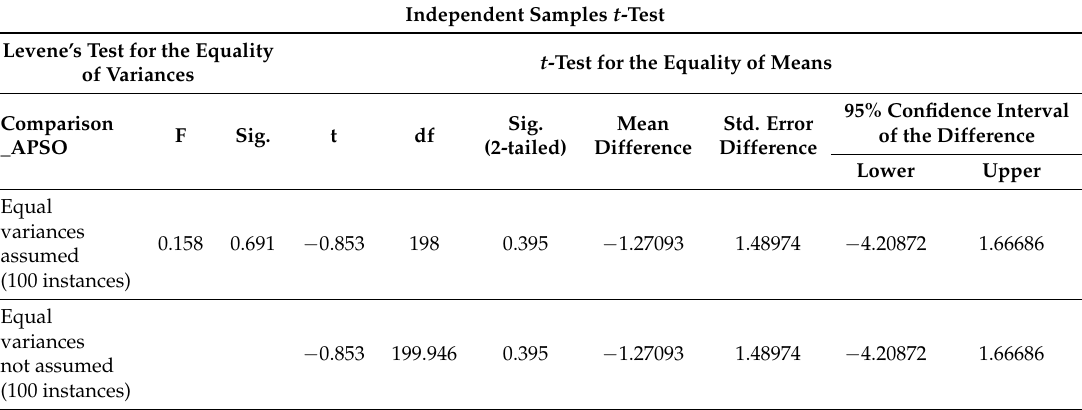
Table 13. SPSS results of the independent sample t -test showing the comparison between simple APSO and improved APSO on the non-pumped storage non-cascaded STHTS problem without transmission losses. Independent Samples t -Test